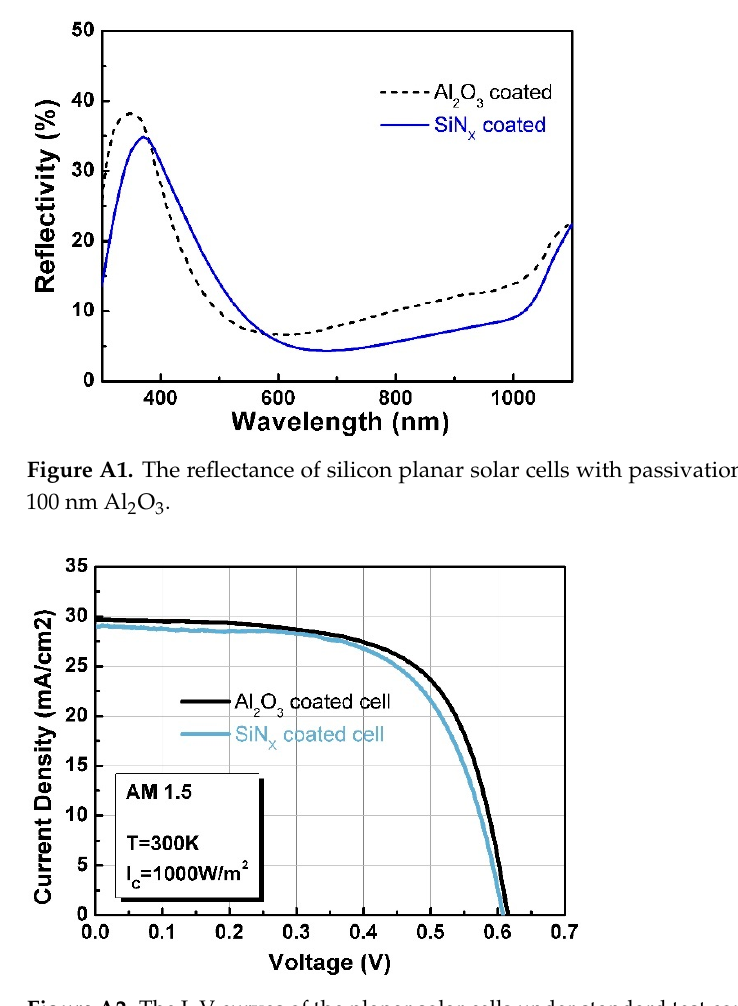
Figure A2. The I–V curves of the planar solar cells under standard test conditions (AM 1.5 irradiation, T = 300 K, and P = 1 kW/m 2 ).